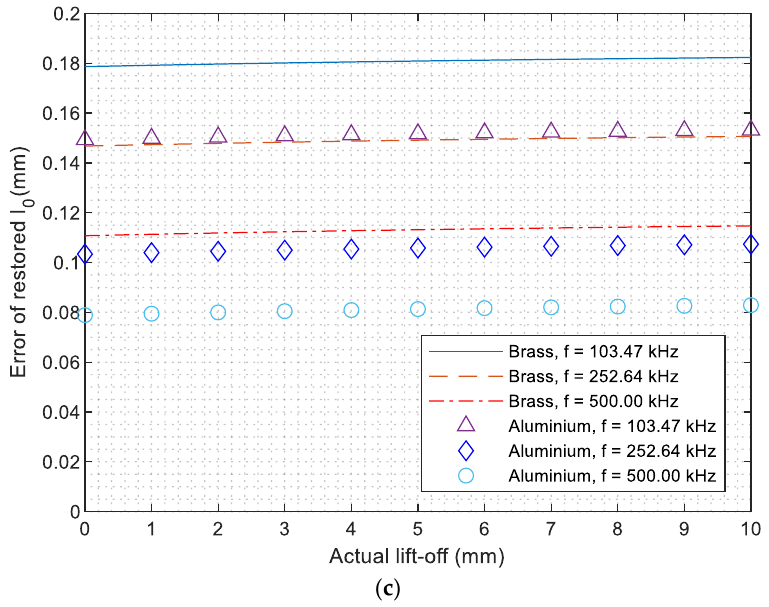
Figure 6. Error of the retrieved lift-off distance for coatings with thickness of ( a ) 0.1 mm, ( b ) 0.3 mm, and ( c ) 0.5 mm.